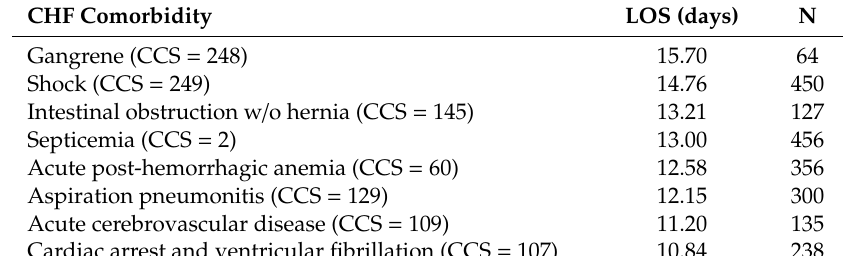
Table 2. Comorbidities (N > 10) with the longest LOS and the highest mortality